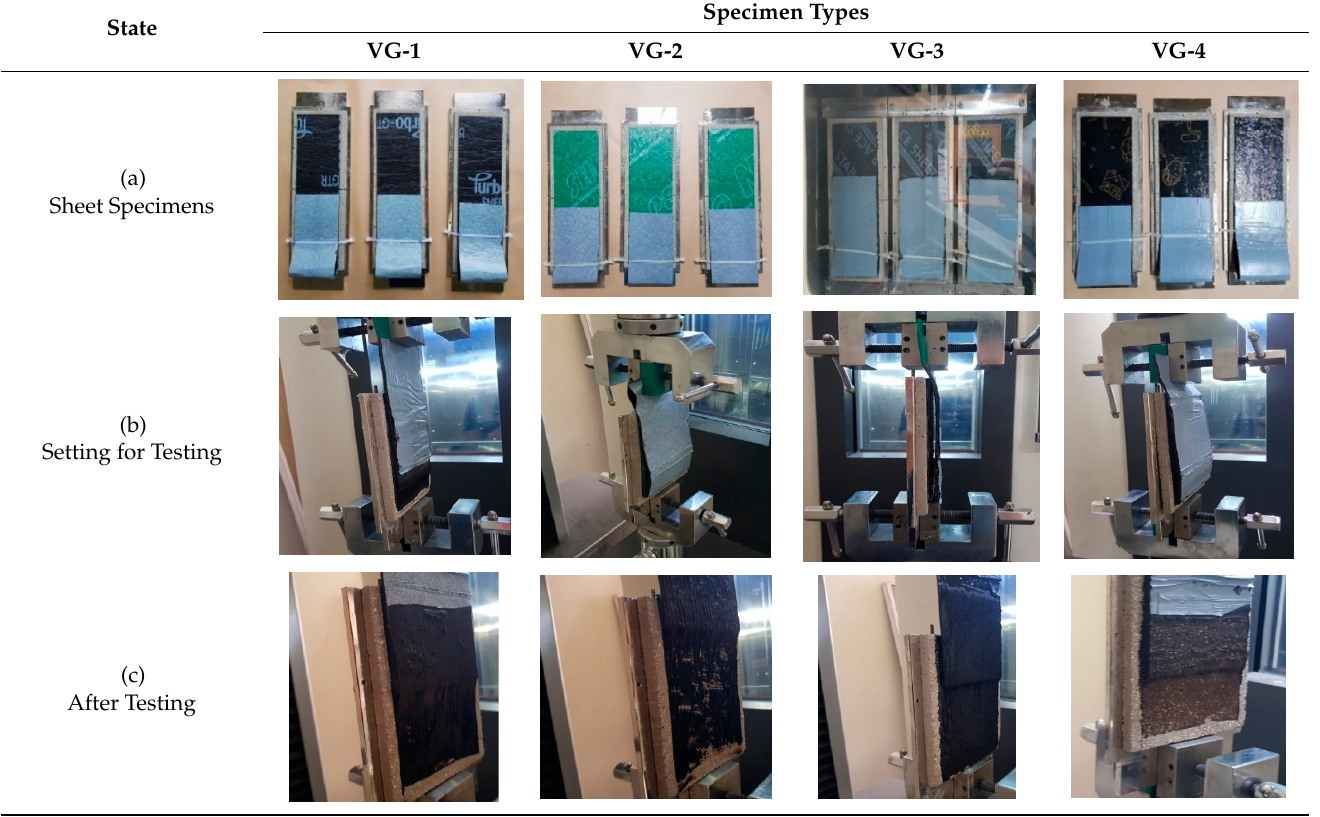
Table 4. The NHV-SPRG composite waterproofing sheet specimen and peel off test summarized.